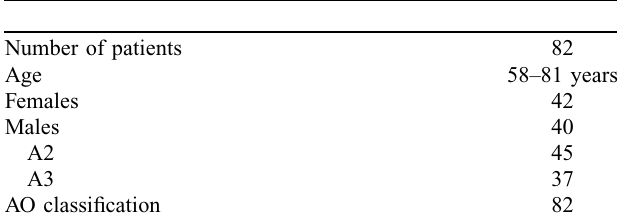
Table 1. Demographic characteristics of the sample ( n =